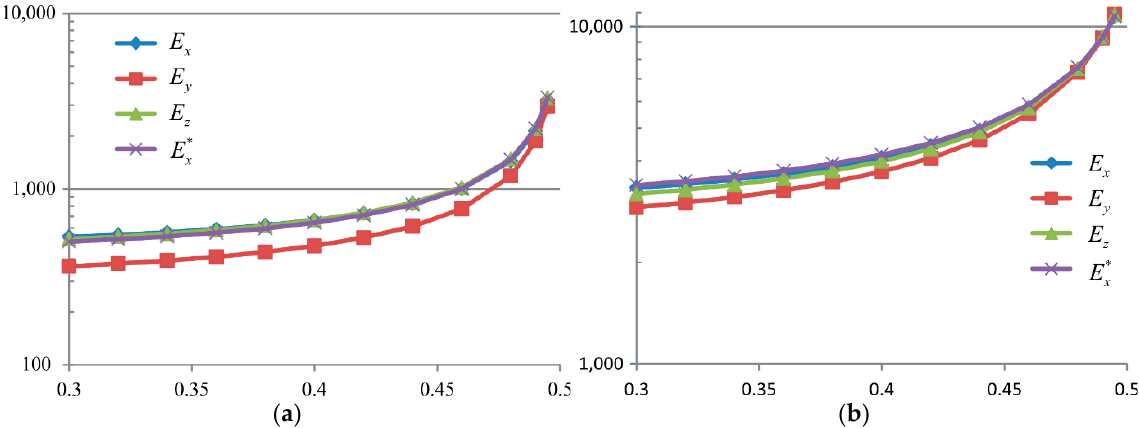
Figure 14. The influence of the mortar’s Poisson ratio on the value of the effective constrained moduli of asphalt concrete with the assumption of the mortar’s Young modulus as ( a ) E r and ( b ) E 0 /the (i) variant/.